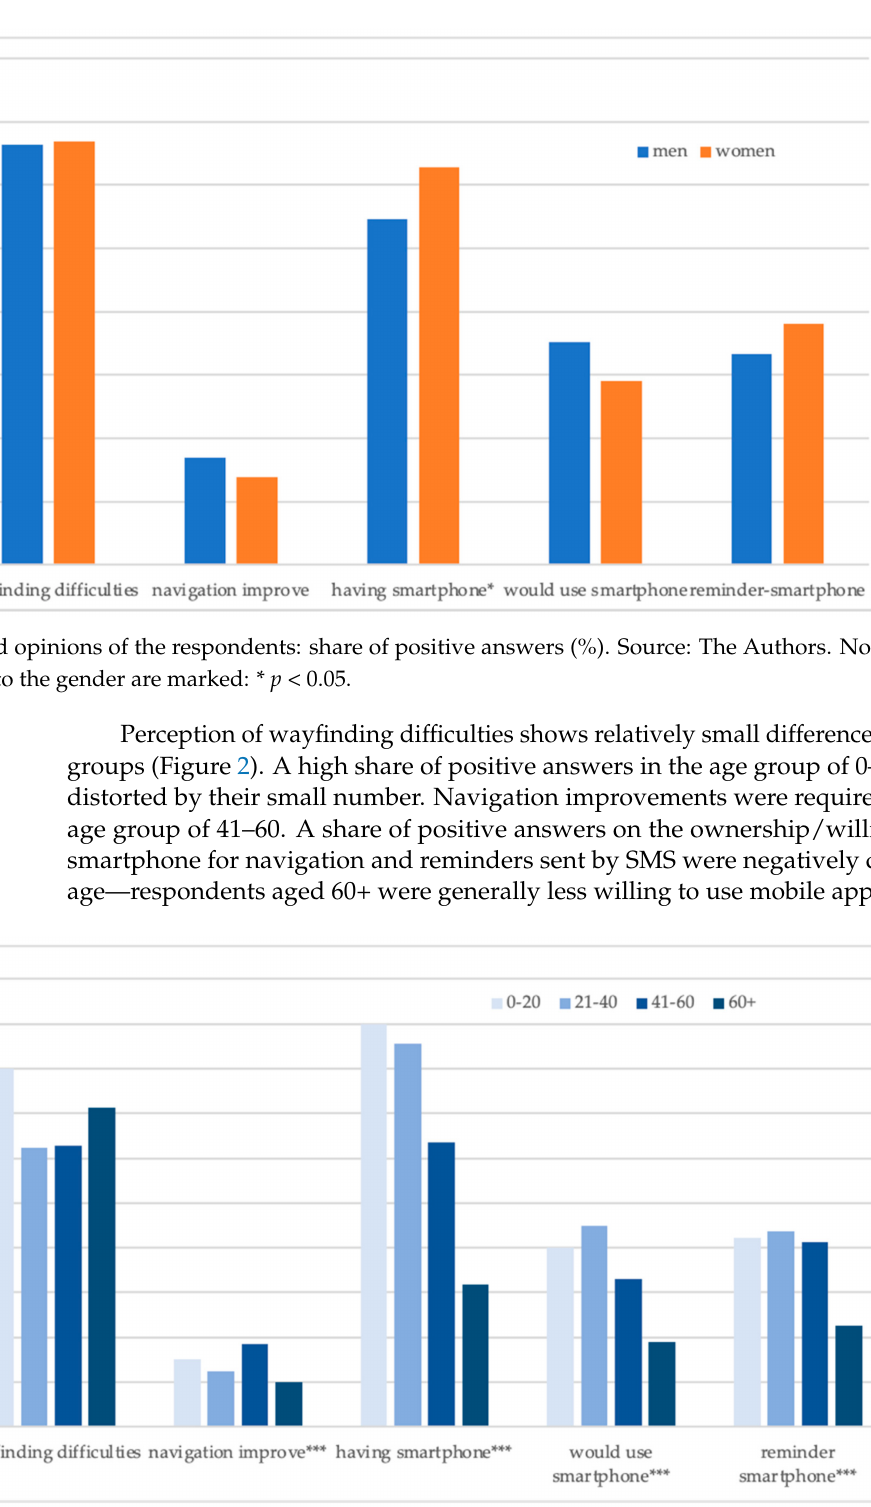
Figure 2. Age and opinions of the respondents: share of positive answers (%). Source: The Authors. Note: variables significantly related to the age are marked: * p < 0.05; ** p < 0.01; *** p <